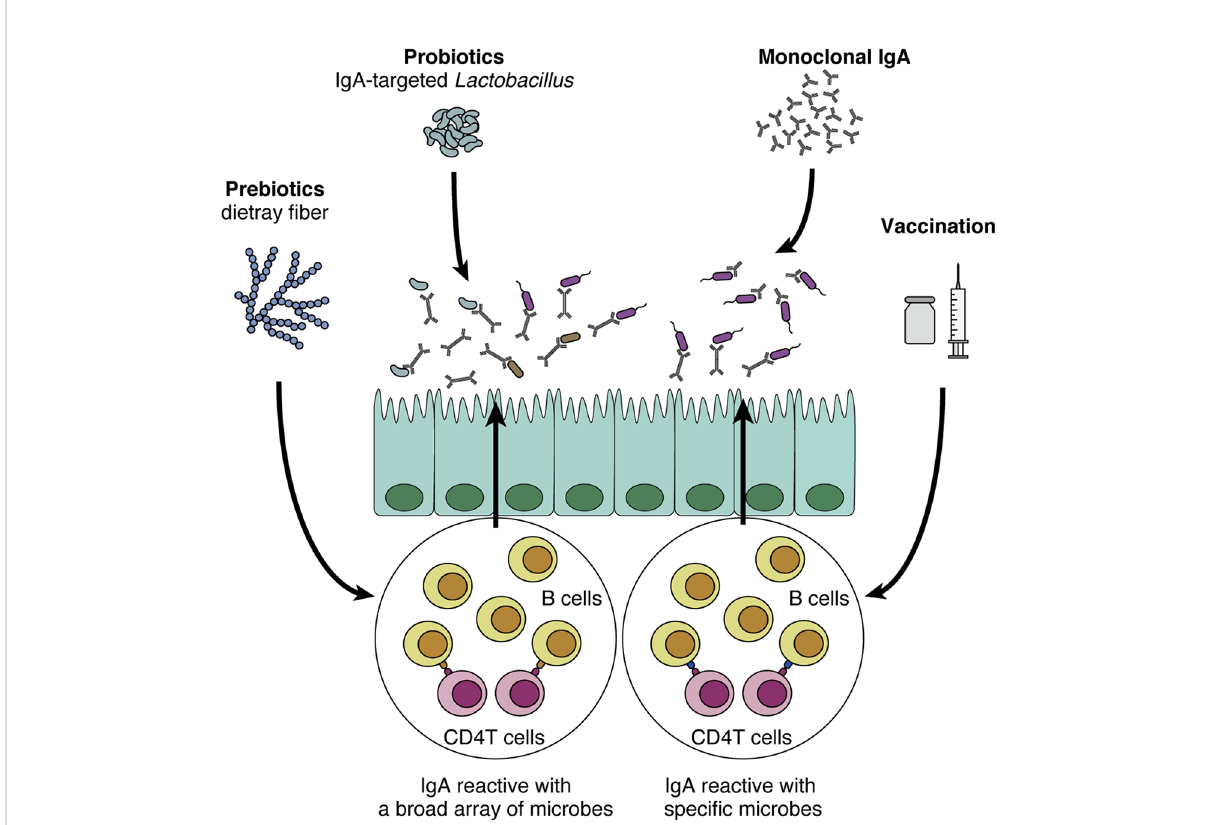
FIGURE 2 Potential application of IgA to human diseases. IgA-oriented therapies that modulate the gut microbiota could be utilized to control disease susceptibility. First, prebiotics (e.g., dietary fi ber) and probiotics increase intestinal IgA production and modulate IgA-coating bacteria. In turn, IgA-coated Lactobacillus could be isolated and harnessed as a probiotic strain that directly interacts with the mucus layer and epithelial cells. Although these methods are relatively easy to implement, their effects on the intestinal immune system are not speci fi c to IgA production. In addition, it is dif fi cult to induce IgA reactive with speci fi c microbes of interest. By contrast, vaccination and monoclonal IgA administration are more sophisticated in the sense that these methods leverage “ speci fi city ” toward certain microbes, a cardinal feature of adaptive immunity. As the ef fi cacy of these methods has been shown in mouse models (e.g., colitis and high-fat diet-induced obesity), these approaches that target speci fi c microbes of interest would be